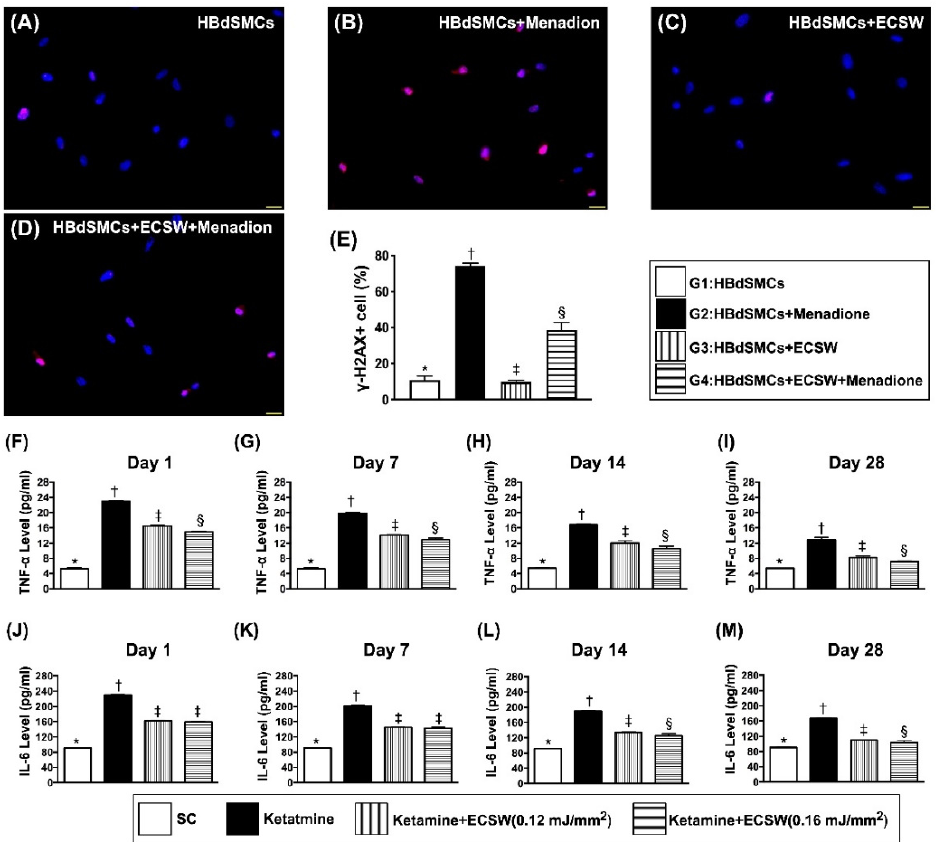
Figure 4. ECSW therapy attenuated menadione-induced DNA damage in RBdSMCs and time courses of urinary level of inflammatory biomarkers. ( A – D ) Illustrating the immunofluorescent microscopic finding (400 × ) for identification of positively stained γ -H2AX cells (pink color). ( E ) Analytical result of number of γ -H2AX+ cells, * vs. other groups with different symbols (†, ‡, §), p < 0.0001. Scale bar in right lower corner represents 20 µ m. ( F – I ) The urine levels of tumor necrosis factor (TNF)- α by days 1 ( F ), 7 ( G ), 14 ( H ) and 28 ( I ), respectively, analytical result of TNF- α in urine, * vs. other groups with different symbols (†, ‡, §), p < 0.0001. ( J – M ) The urine levels of interleukin (IL)-6 by days 1 ( J ), 7 ( K ), 14 ( L ) and 28 ( M ), respectively, analytical result of interleukin (IL)-6 in urine, analytical result of IL-6 in urine, for days 1 and 7, * vs. other groups with different symbols (†, ‡), p < 0.0001; for days 14 and 28, * vs. other groups with different symbols (†, ‡, §), p < 0.0001. All statistical analyses were performed by one-way ANOVA, followed by Bonferroni multiple comparison post hoc test ( n = 6 for each group). Symbols (*, †, ‡) indicate significance (at 0.05 level). ECSW = extracorporeal shock wave; RBdSMCs = rat bladder smooth muscle cells.